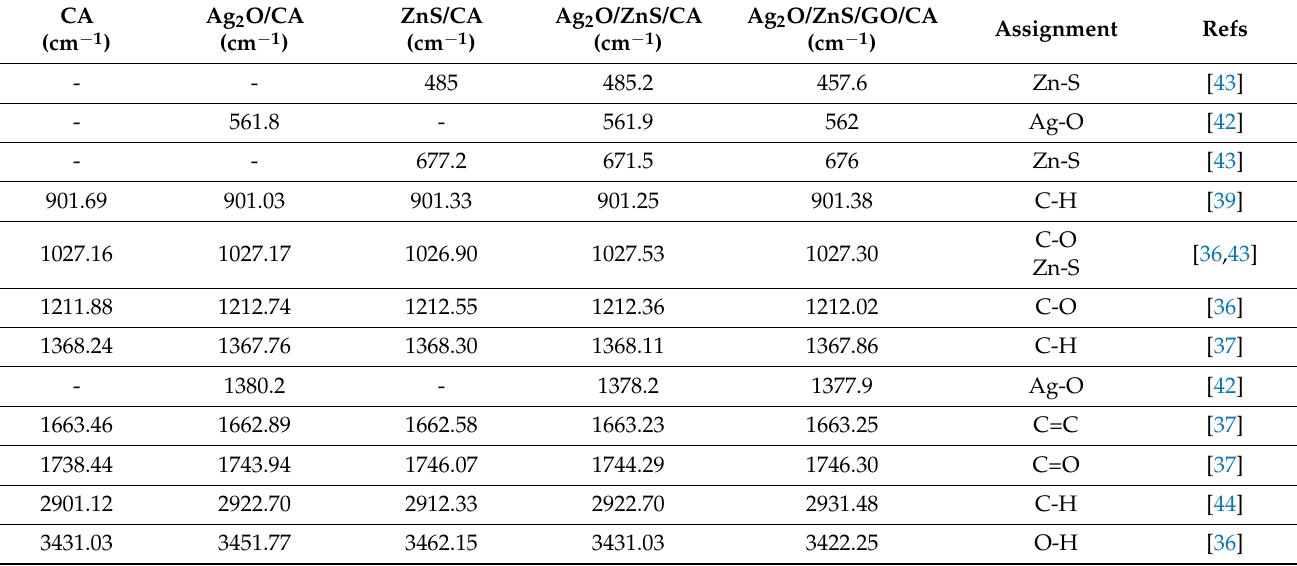
Table 1. The detected bands by FTIR technique and their